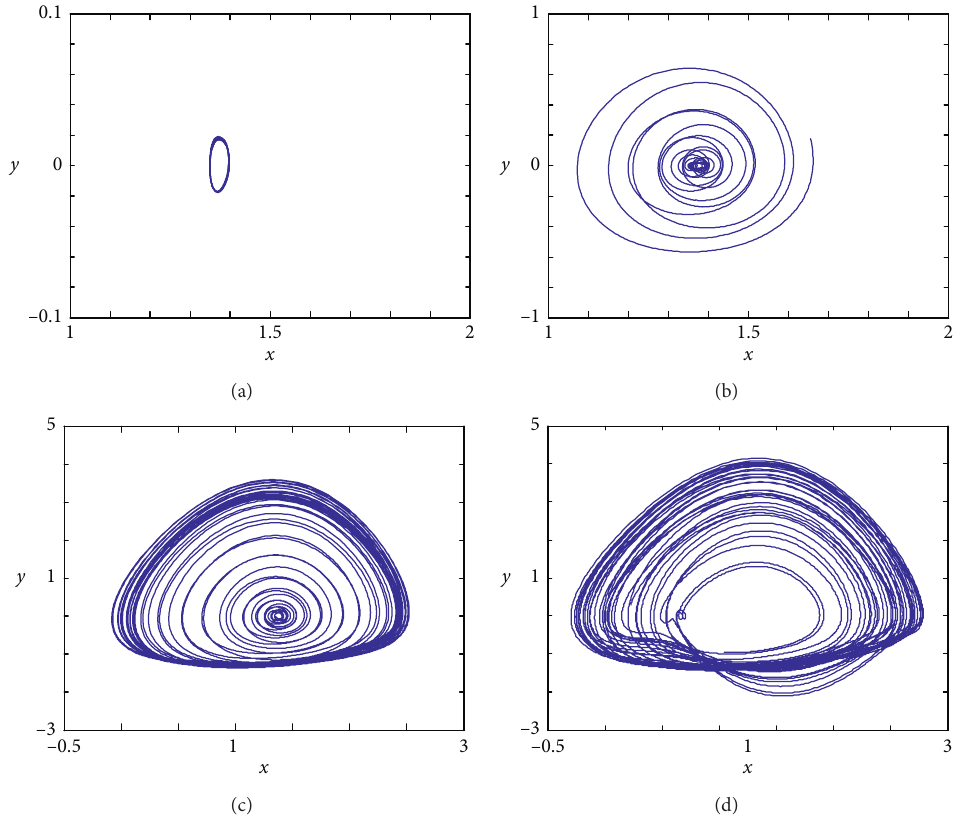
Figure 4: Phase diagrams with different derivative orders: (a) q � 0.94; (b) q � 0.968; (c) q � 0.972; (d) q � 0.99.